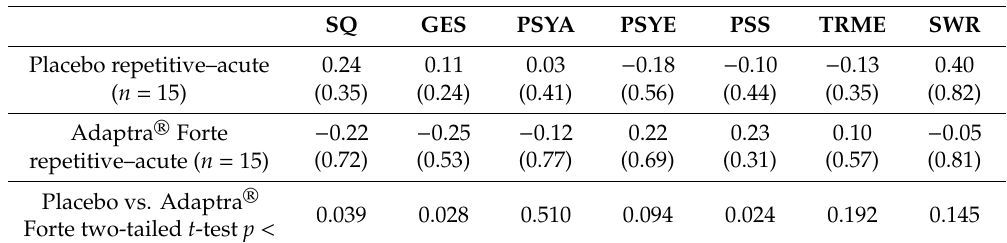
Table 5. Results from (SF-B / R) sleep questionnaire. The questionnaire was filled out before the intake of the study medication. SQ, sleep quality; GES, feeling refreshed after sleep / feeling of being recovered after sleep; PSYA, psychic well-balanced feeling in the evening; PSYE, psychic exhausted feeling in the evening; PSS, psychosomatic symptoms during sleep; TRME, dream recall; SWR, sleep–wake regulation. Mean values are given ± standard